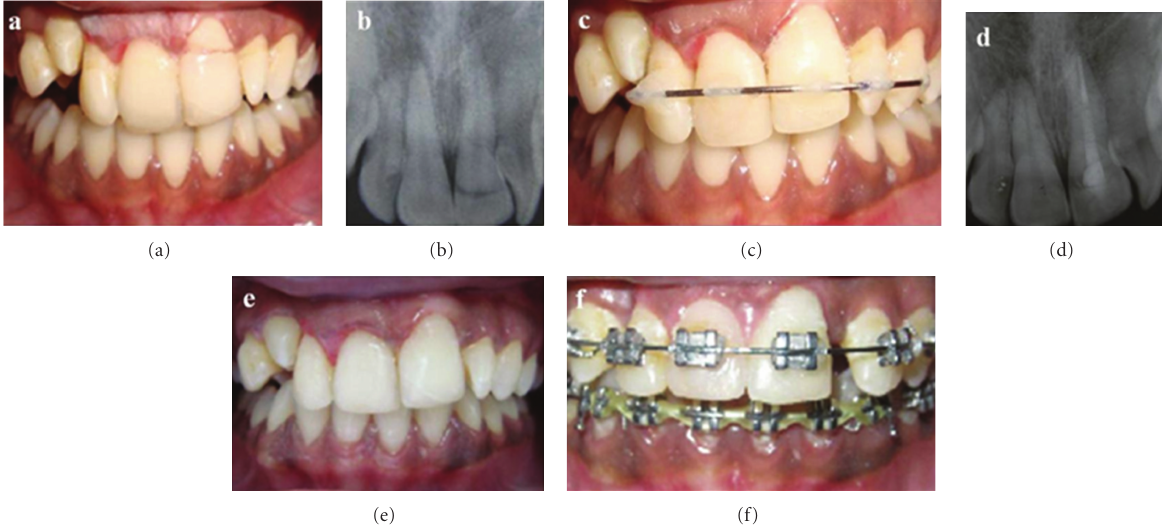
Figure 2: Reattachment of fractured tooth segments and reinforcing the attachment by pre-fabricated fiber post. (a) Clinical appearance of the patient, (b) preoperative radiograph, (c) reattachment of fractured tooth segment, and splinting with stainless steel wire and light cure composite resin, (d) radiograph showing fiber post reinforcing the attachment, (e) clinical view after removal of the splint, and (f) clinical view showing orthodontic treatment in